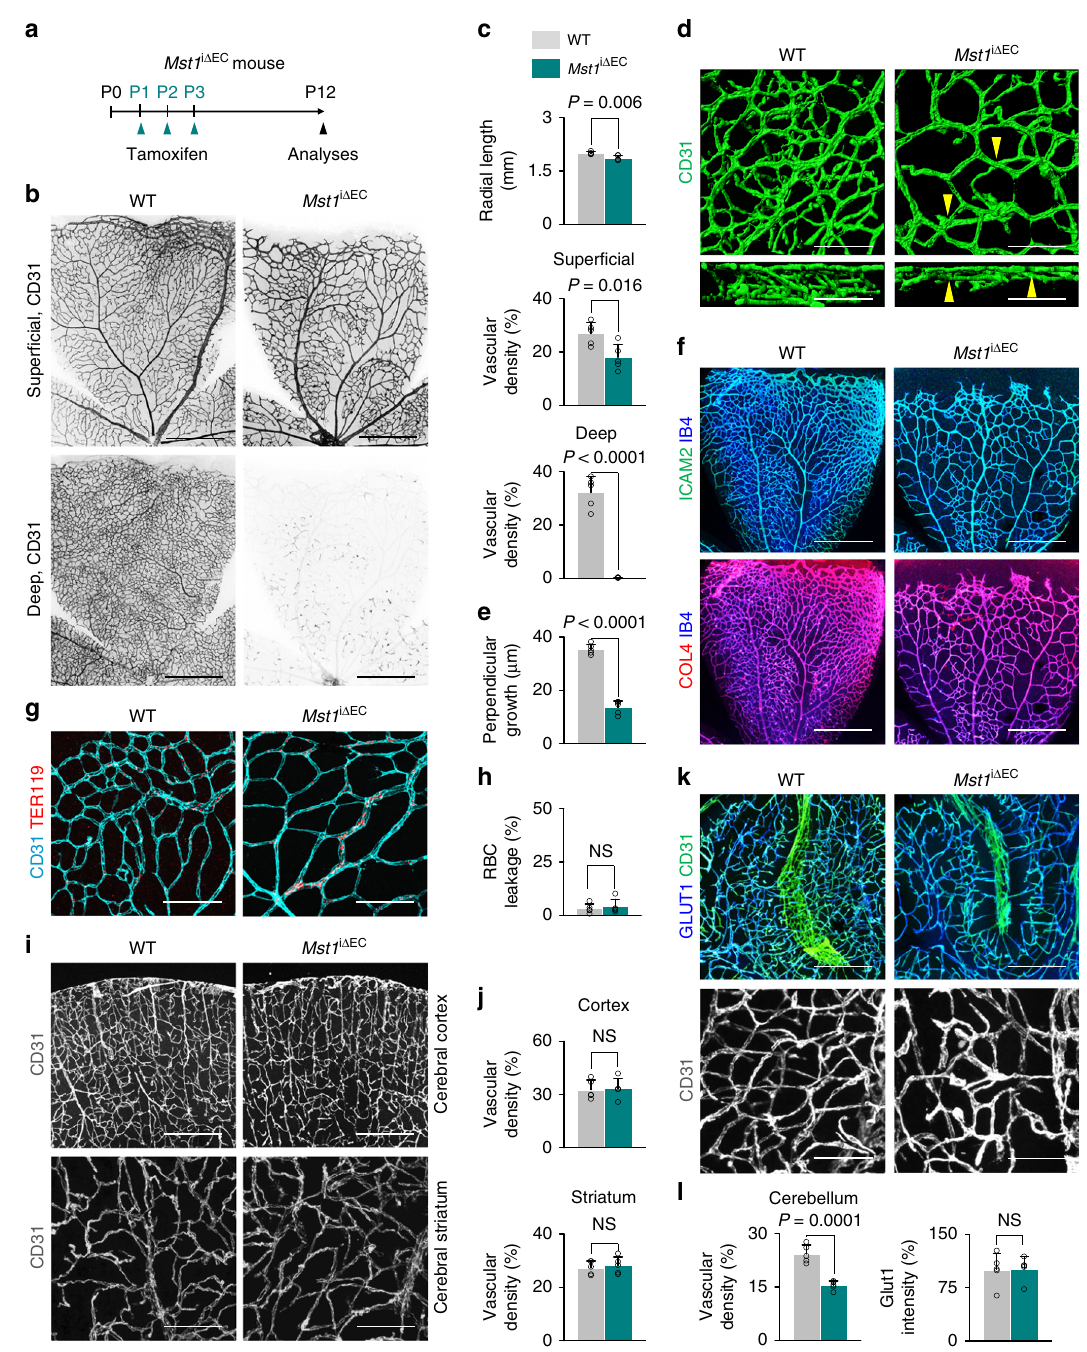
Fig. 2 MST1 is crucial for perpendicular vascular branching. a Diagram depicting the experimental schedule for EC-speci fi c deletion of MST1 in retinal vessels from P1 and their analyses at P12 in Mst1 i Δ EC mice. b , c Images of CD31 + vessels in super fi cial and deep layers of retina and comparisons of indicated parameters in WT ( n = 5) and Mst1 i Δ EC ( n = 5) mice. Scale bars, 500 μ m. d , e 3D reconstructed images of CD31 + vascular plexus and comparisons of the length of perpendicular growth in WT ( n = 5) and Mst1 i Δ EC ( n = 5) mice. Note that aberrant vessel crossings (yellow arrowheads) are shown. Scale bars, 50 μ m. f Images showing IB4 + vessels, ICAM2 + lumen formation and COL4 + collagen deposition in WT and Mst1 i Δ EC mice at P12. Scale bars, 500 μ m. g , h Images of TER119 + RBC and CD31 + retinal vessels, and comparison of RBC leakage in WT ( n = 5) and Mst1 i Δ EC ( n = 5) mice. Scale bars, 100 μ m. i , j Images of CD31 + vessels and comparison of vascular density at cerebral cortex and striatum in WT ( n = 5) and Mst1 i Δ EC ( n = 5) mice. Scale bars, 200 μ m. k , l Images of CD31 + vessels and comparisons of indicated parameters at cerebellum in WT ( n = 5) and Mst1 i Δ EC ( n = 5) mice. Scale bars, 200 μ m. Data represent mean (bar) ± s.d. (error bars). P values, versus WT by two-tailed unpaired t -test. NS not signi fi cant. Source data are provided as a Source Data fi